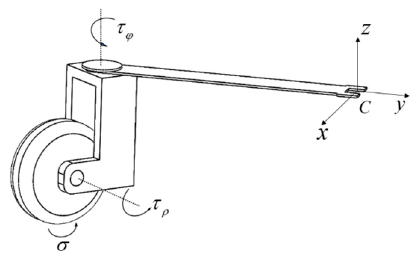
Figure 4. Simplified PCW model subjected to driving torques.